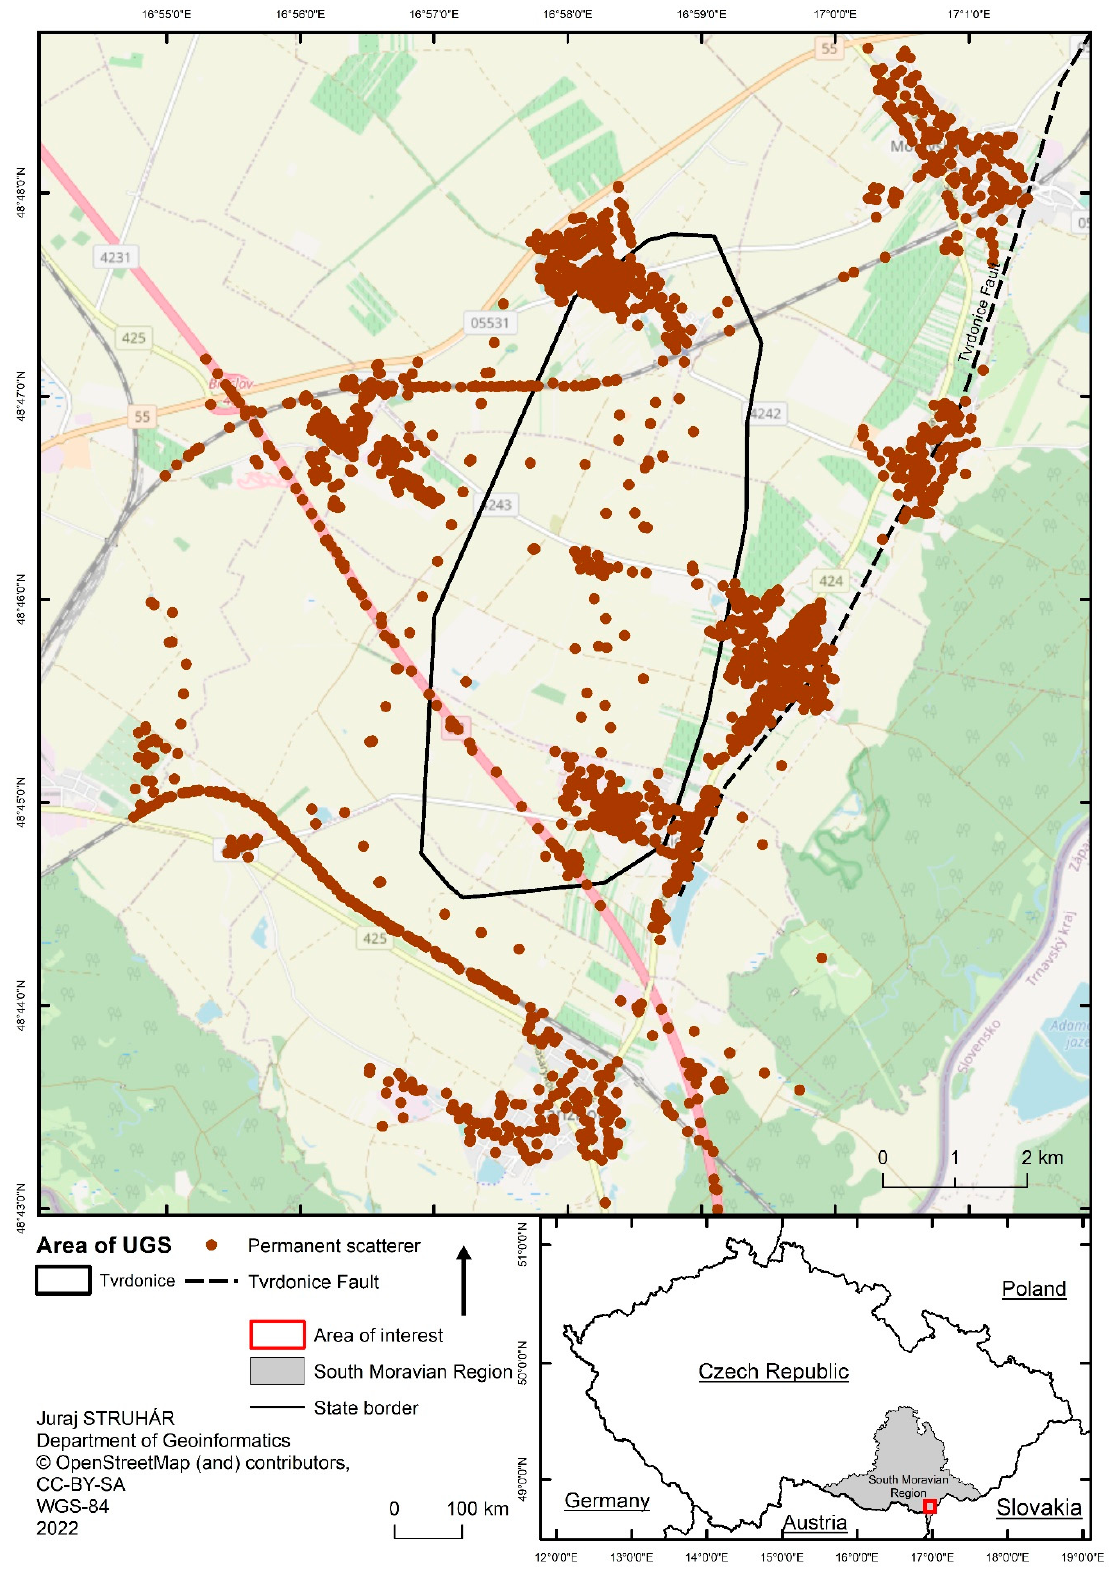
Figure A2. Situation of UGS Tvrdonice and distribution of permanent scatterers, generated by PS InSAR and used for visualisation.